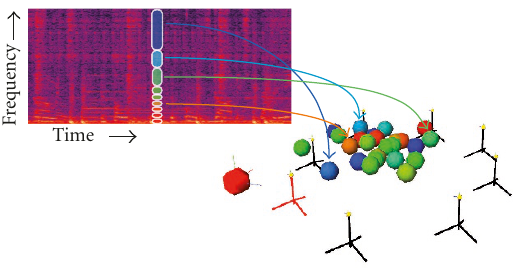
Figure 9: In the resynthesis phase, the frequency components of the signal captured by the microphone closest to the location of the virtual listener (shown in red) is warped according to the spatial mapping precomputed in the o ff -line